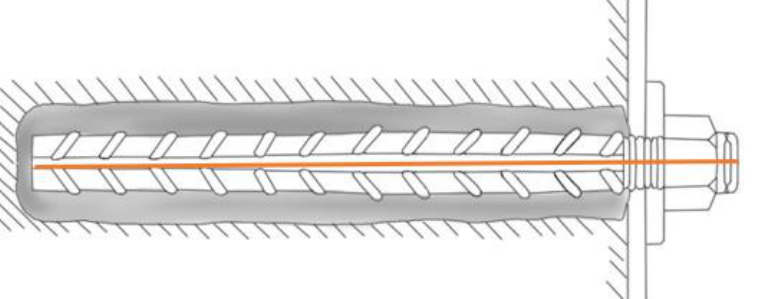
Figure 21. Rock bolt with an integrated sensor developed within the scope of the IlluMINEation project.